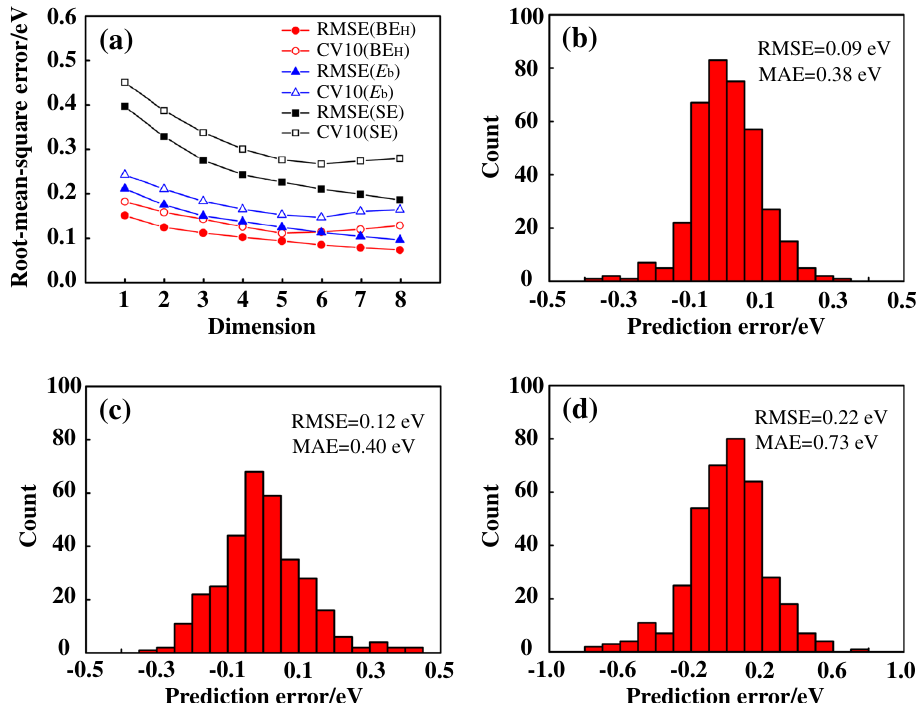
Fig. 2 SISSO errors and their distribution for different target properties. a RMSE and the averaged RMSE of the 10 fold cross-validation. b – d Distribution of errors for the best models versus RPBE results for BE H ( b ), E b ( c ), and SE ( d ). Table 2 The identi fi ed descriptors and the coef fi cients and correlations in corresponding SISSO models for BE H , E b , and SE.